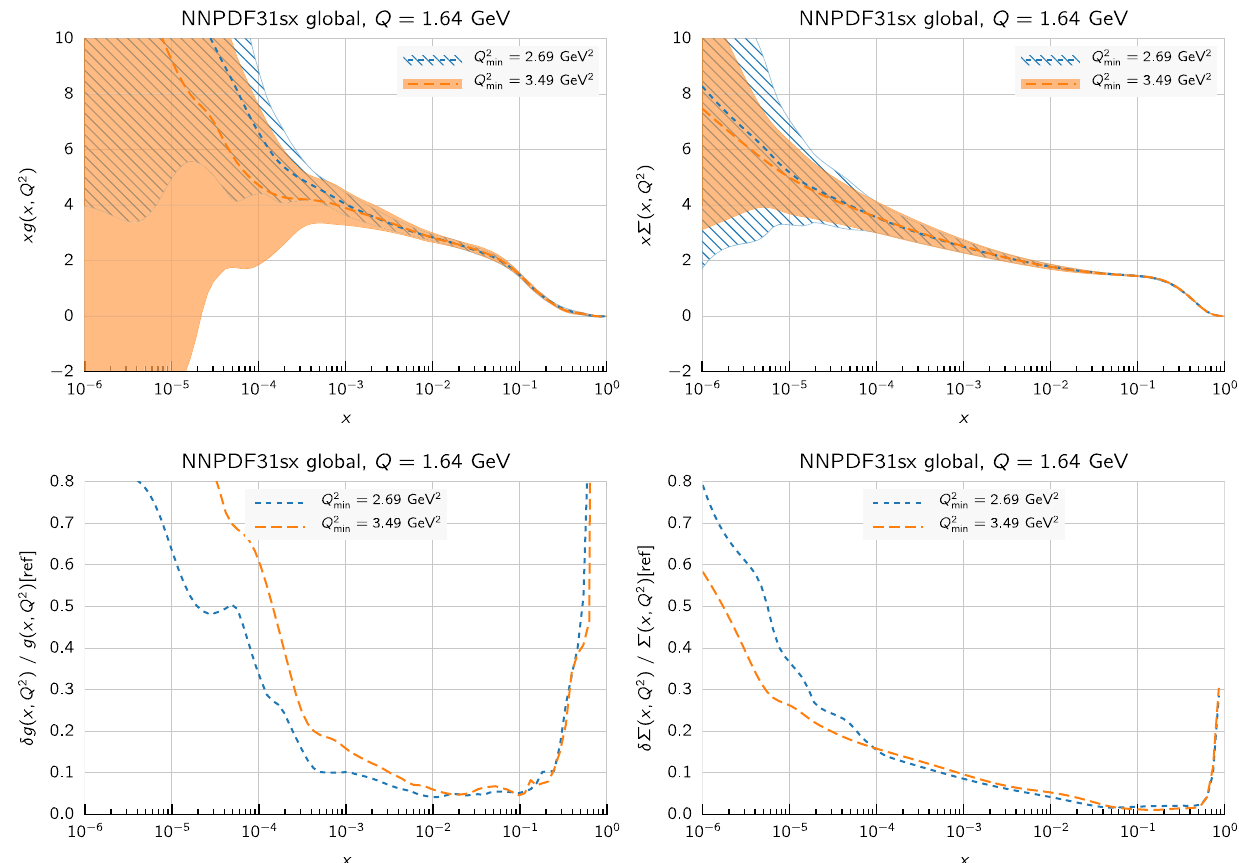
(upperplots)togetherwiththecorrespondingrelativePDFuncertainties (lower